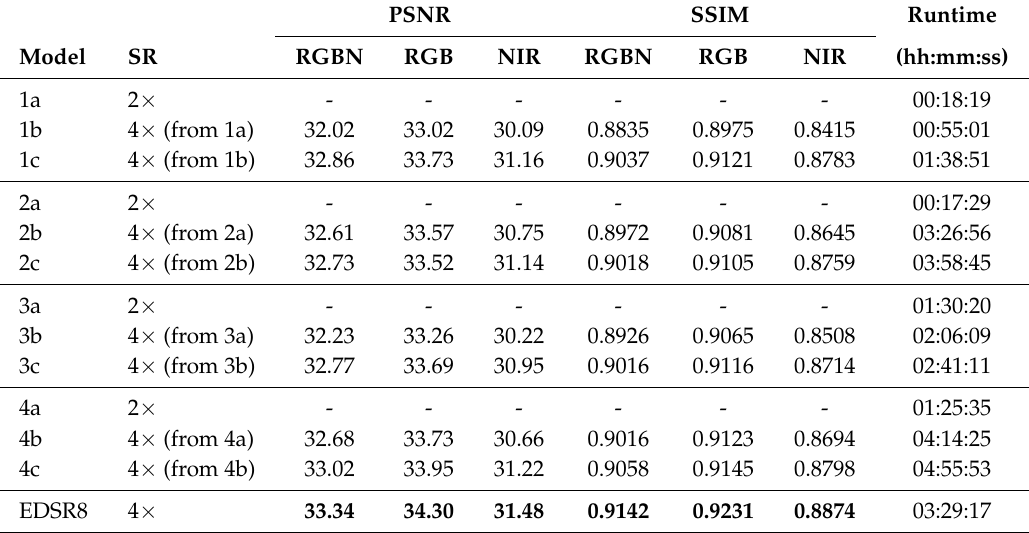
Table 9. PSNR, SSIM and runtimes obtained by EDSR8 with progressive resizing technique using L 1 + L fs RGB + L NDVI loss function and TTA in the test set.